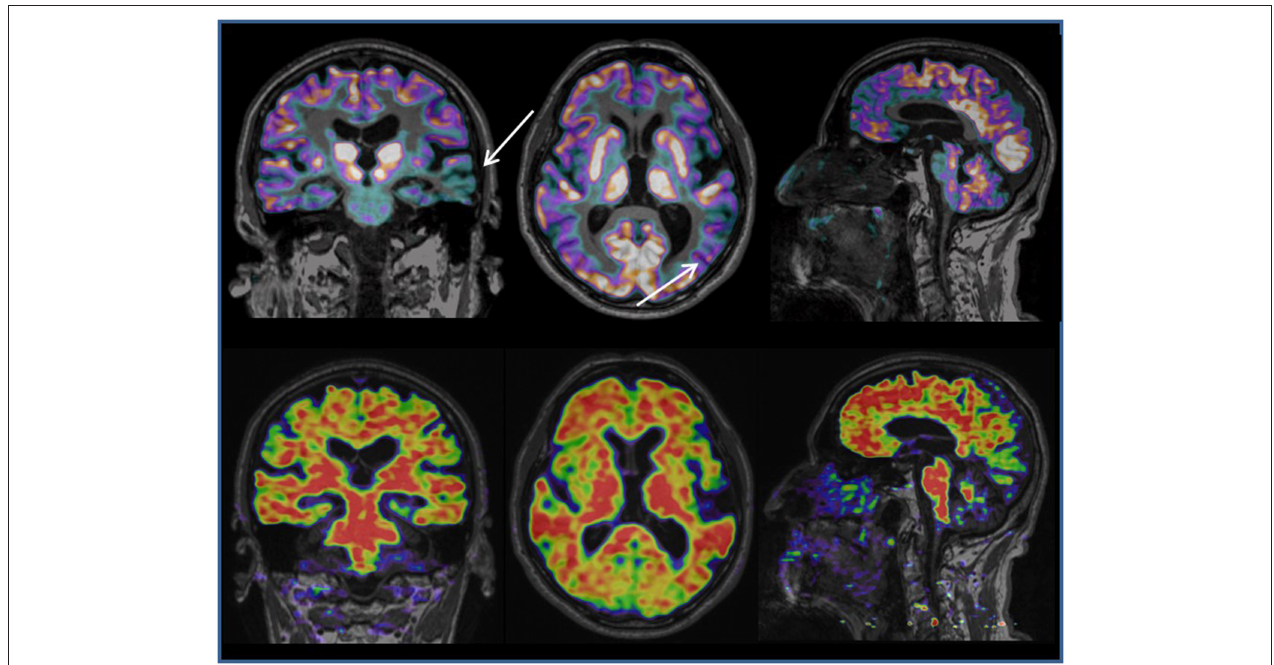
FIGURE 4 | Hybrid PET/MRI imaging (Biograph mMR, Siemens). The picture above shows MRI 3D T1-weighted and 18FDG PET coronal, axial and sagittal slices in a patient affected by progressive speech disorder. The combined structural and metabolic image shows focal atrophy and reduced glucose metabolism in the left temporal lobe (white arrows), suggesting a diagnosis of Primary Progressive Aphasia, a rare form of dementia. The picture below shows MRI 3D T1-weighted and a 18F-flumetamole PET coronal, axial and sagittal slices in the same patient. The combined structural and molecular (Aß amyloid accumulation) image shows a diffuse increase in Aß amyloid deposits in the cortex, supporting the diagnosis of brain neurodegenerative